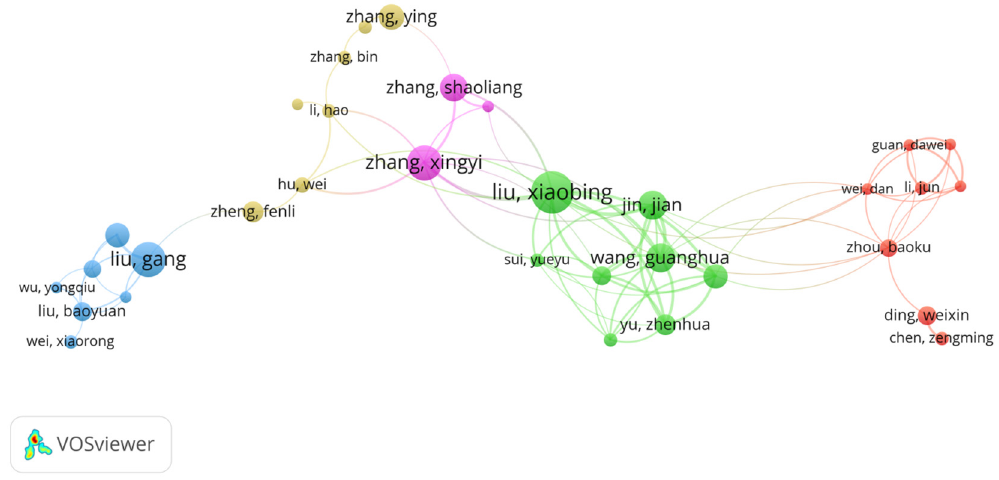
Figure 2. Clustering mapping of author collaboration networks for BSC domain publications. Table 1. Information on the top 20 authors in terms of number of publications.